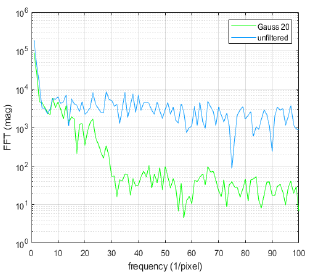
Figure 11. Fourier spectrum of Gauss filtered with σ = 20 (pixel) and